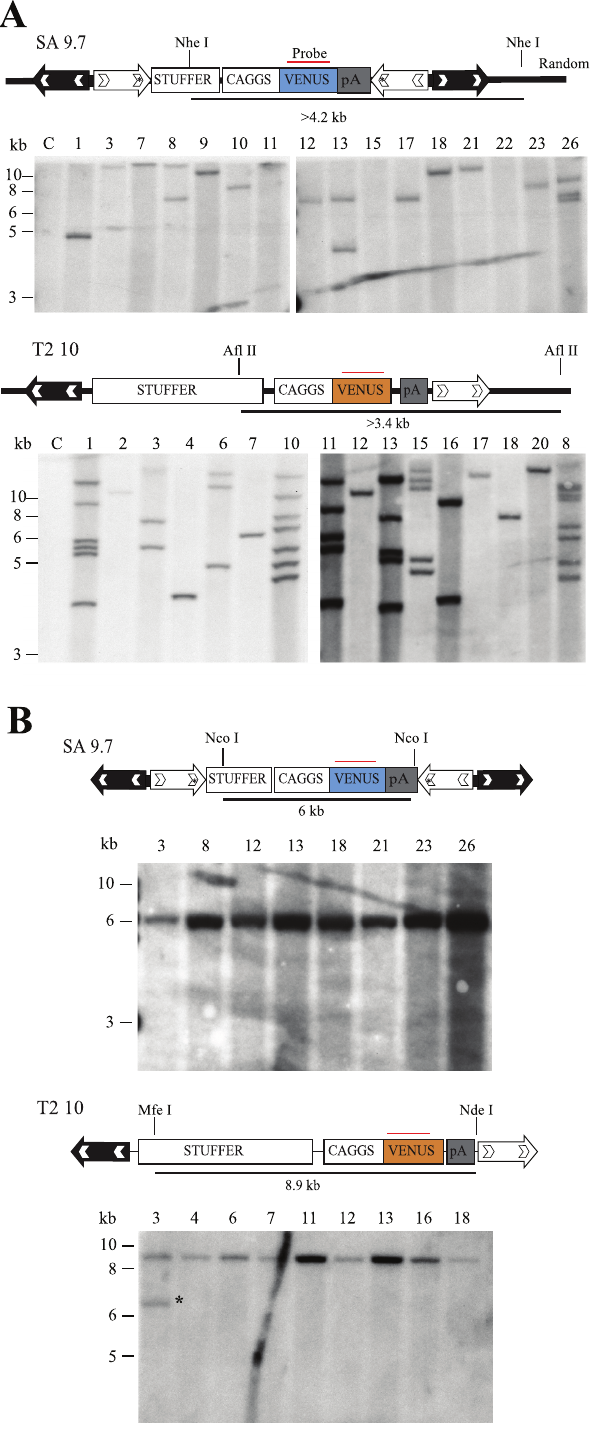
Figure 3. Molecular characterization of the SleepingBeauty -mediated integration events in GABEB cell clones. (A) Southern blot analysis of genomic DNA from GABEB cell clones digested with NheI (SA clones) or AflII (T2 clones), single cutter in the transposon cassette, and hybridized to a Venus probe. A single band higher than 4.2 kb (SA clones) and 3.4 kb (T2 clones) indicates integration of one copy of the transposon into the genome. Multiple Venus-specific bands correspond to repeated integration events. (B) Southern Blot analysis of genomic DNA from 8 (SA) and 9 (T2) clones digested with NcoI (SA clones) or MfeI and NdeI (T2 clones). The expected Venus-specific band corresponding to 6 kb for SA and 8.9 kb for T2 transposon indicates the correct integration of the transposons into the genome. C, mock-transfected cells; red bars, Venus-specific probe. Clone showing rearrangement of the transposon cassette is highlighted by black asterisk. ( C ) Bi-directional mapping of the junctions between transposon and genomic DNA. The table summarizes 27 integrations belonging to 10 single clones. For each integrant, the underlined sequence